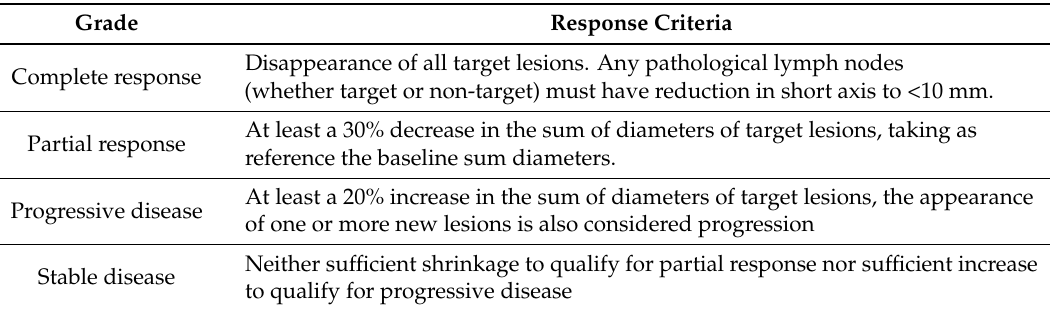
Table 1. RECIST response criteria, version 1.1.